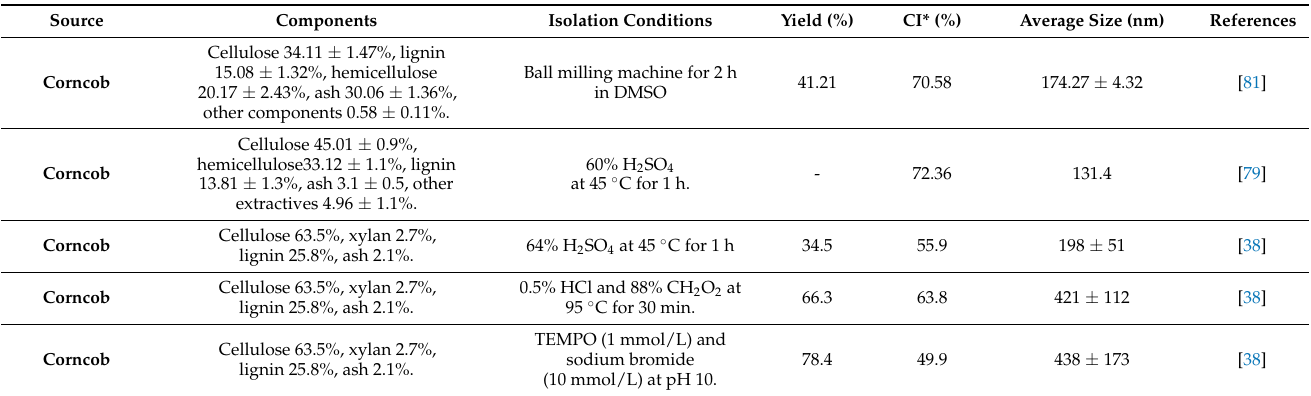
Table 2. Selected examples presenting the extraction of CNCs from corncob